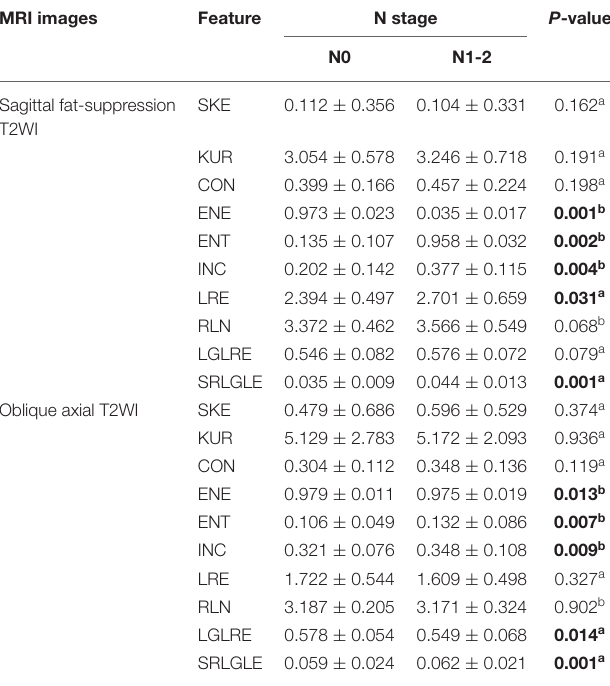
TABLE 3 | Differences in texture features between stage N0 and N1-2